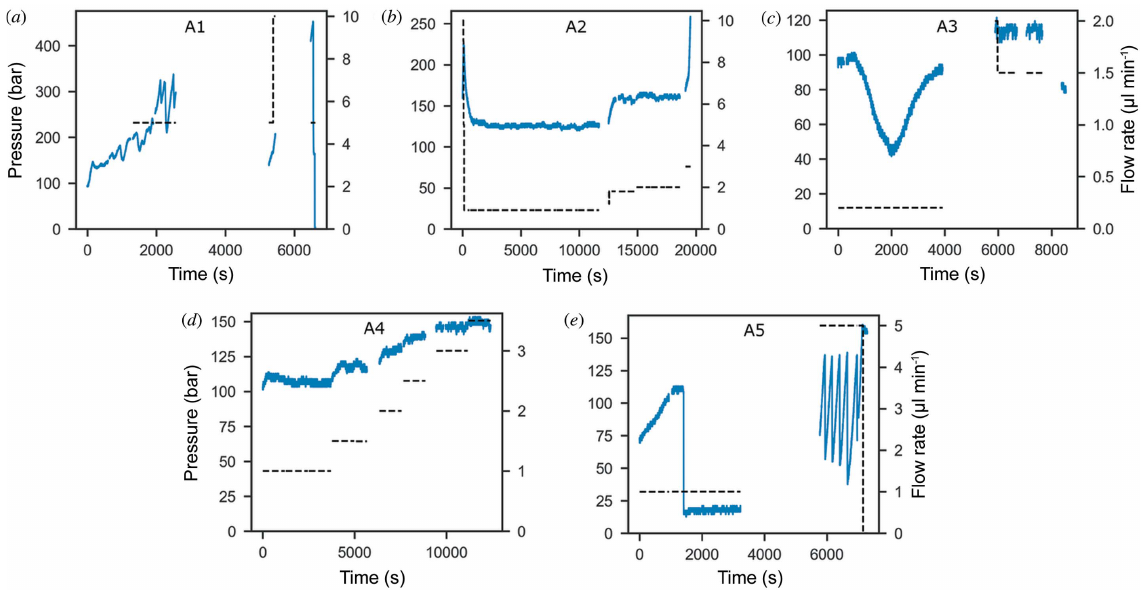
Figure 5 Variation of pressure and flow rate during the synchrotron experiment. Pressure is depicted by the solid blue line; the dashed black line is the flow rate. Breaks in the plot correspond to periods where data were not collected. Flow rate was adjusted manually through the HPLC pump in order to maintain a steady flow. The true flow rate of the sample leaving the nozzle may be different, particularly when the ‘saw-toothing’ behaviour occurs. In general, the true flow rate also lags a change in the HPLC set point as the sample takes some time to adapt. Plots ( a )–( f ) depict data for samples A1–A5, respectively. See Table 1 for sample